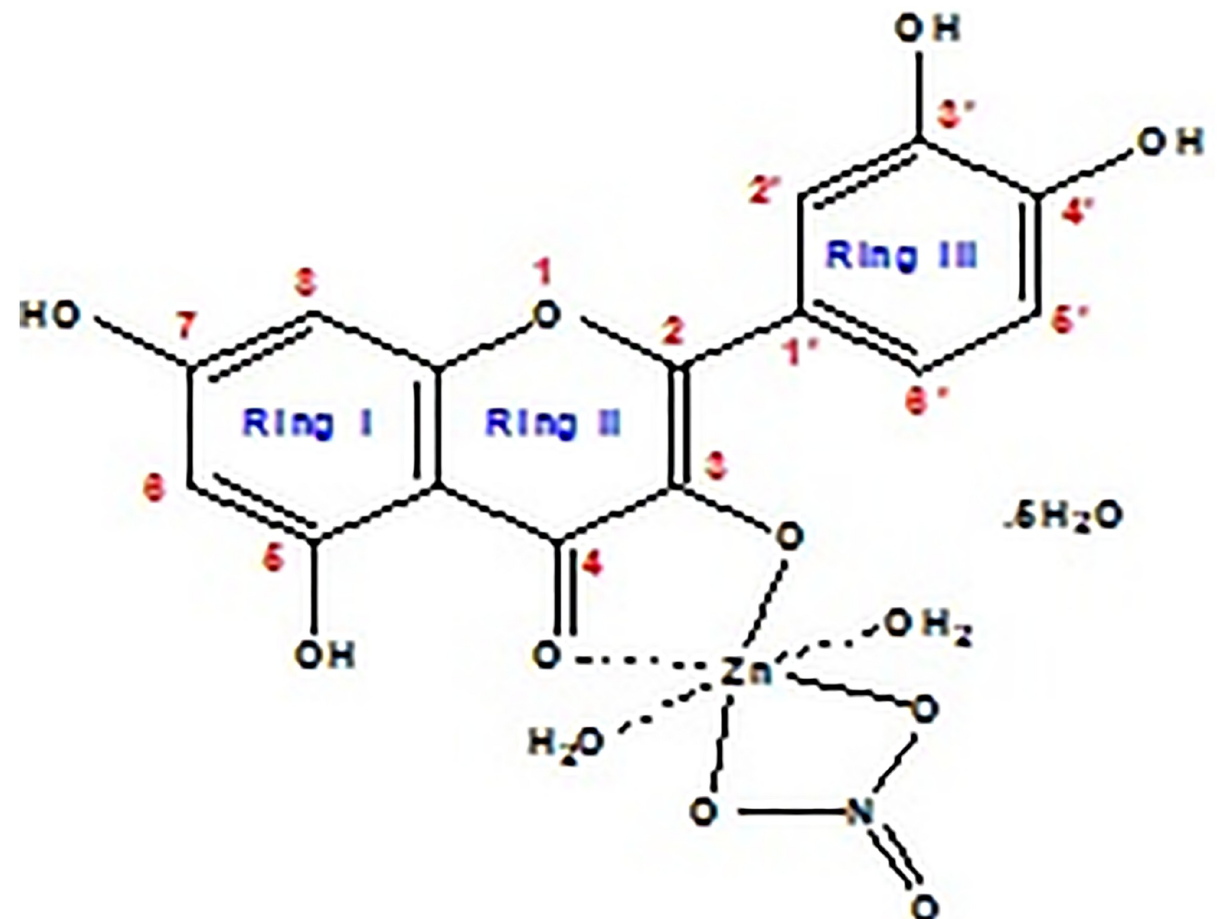
Fig 2. Speculated structure of Q/Zn